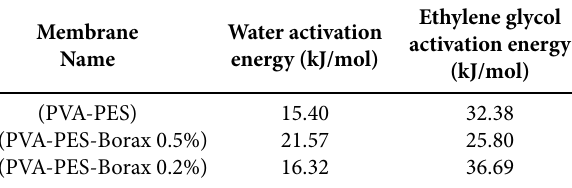
Table 5. Apparent activation energy of water and ethylene glycol permeation through PVA-PES composite membranes cross linked with